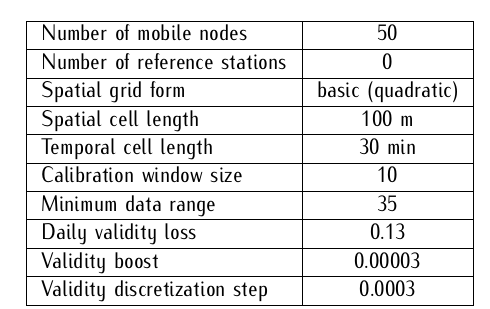
Table 1. Scheme parameters of simulation